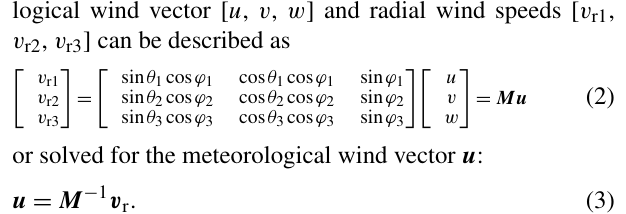
Table 2. List of periods with adaptive multi-Doppler measurements. The column “reference” indicates if wind direction reference was obtained from VAD scans or meteorological tower 20/tse04. In bold are the periods that are looked at in detail in this